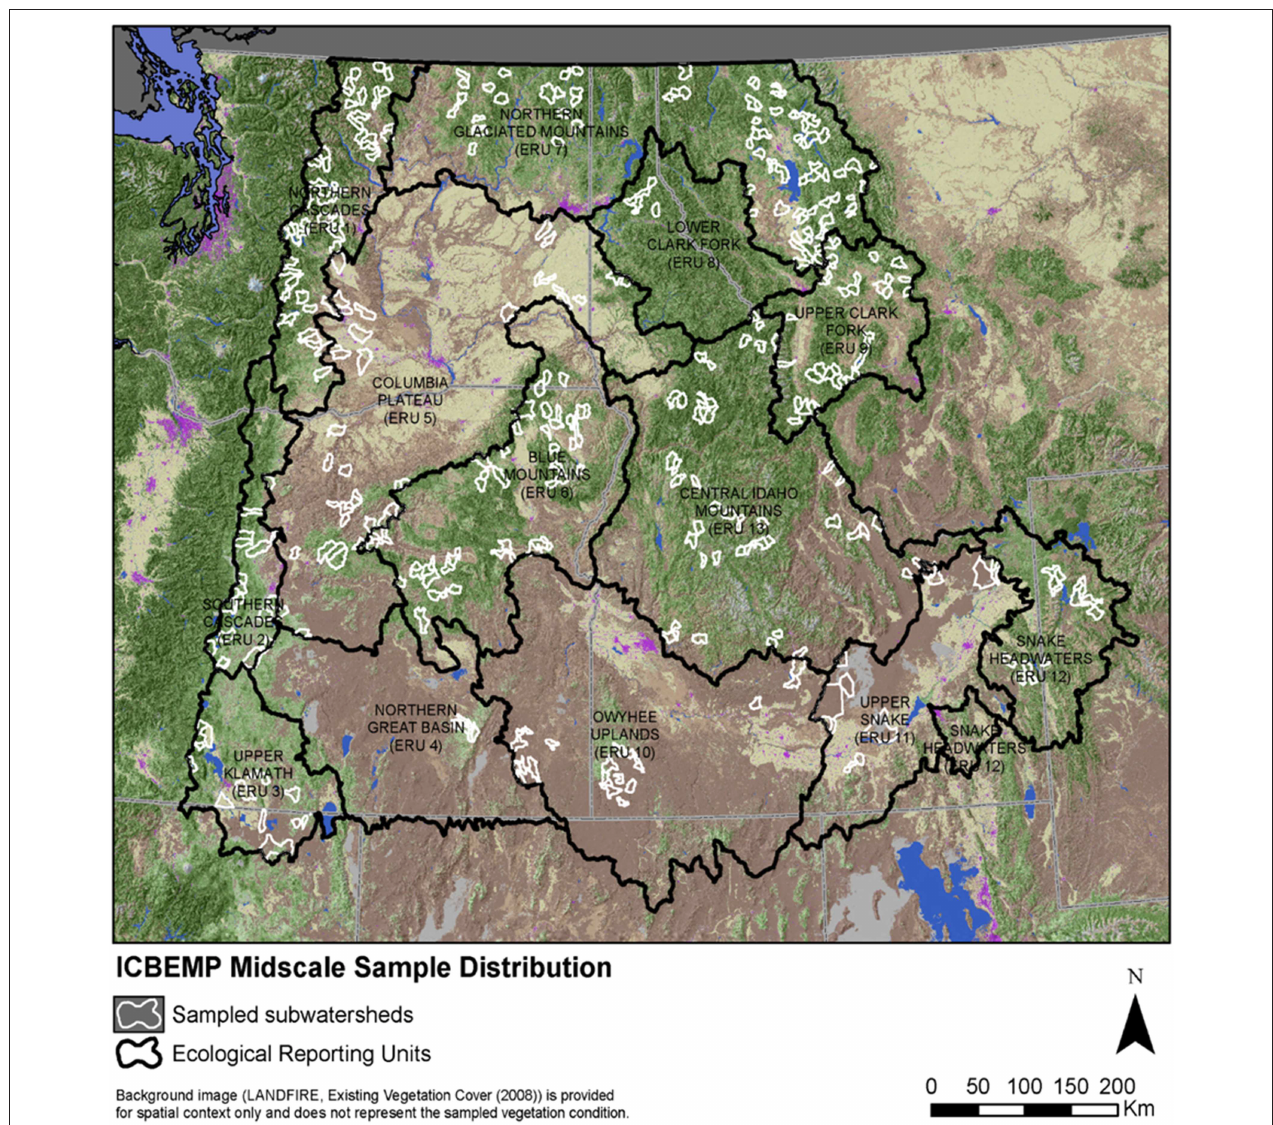
FIGURE 7 | Map of sampled subwatersheds in provinces (Ecological Reporting Units-ERUs) of the Interior Columbia River Basin assessment. Subwatersheds were sampled in a two-stage, stratified random sample of subwatershed conditions of broad province-scale ecological reporting units (ERU’s, Hessburg et al.,